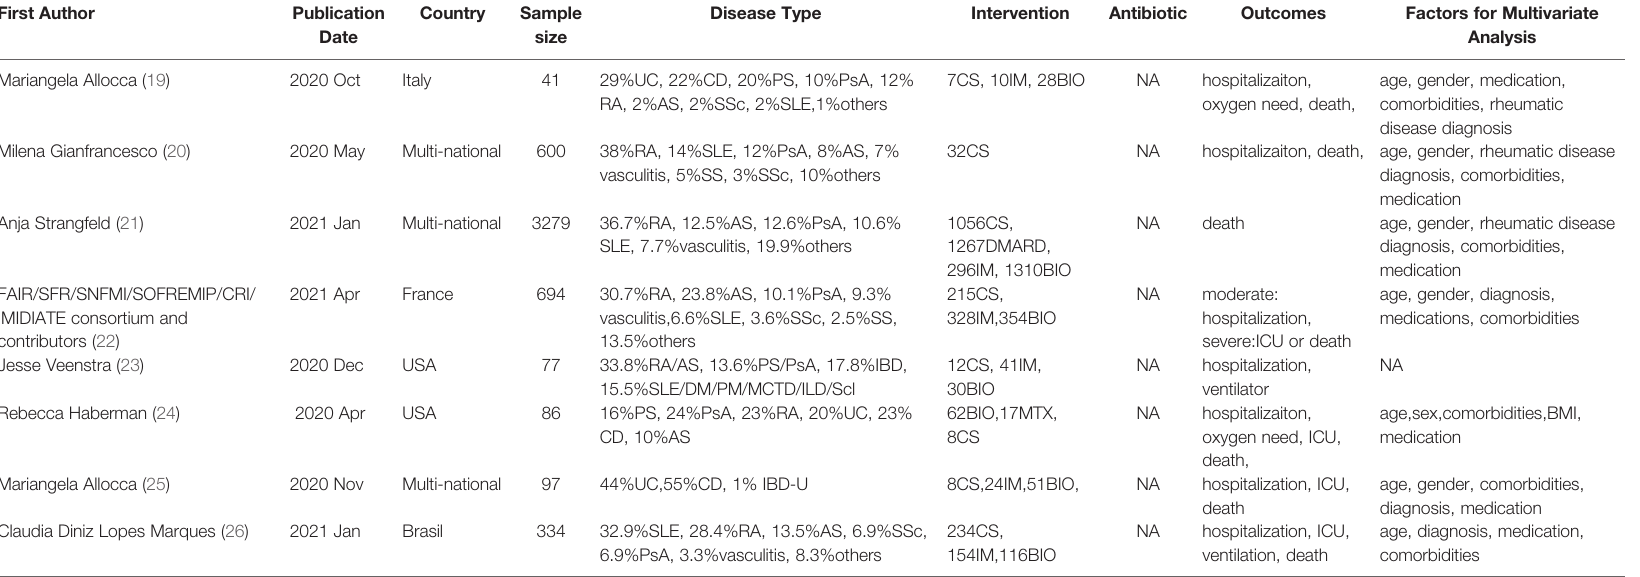
TABLE 1 | Baseline characteristics of cohort studies